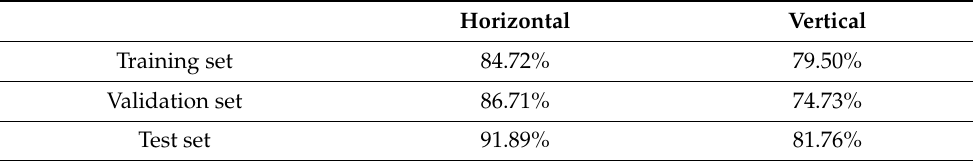
Table 5. The accuracy of both optimal orientation estimators.